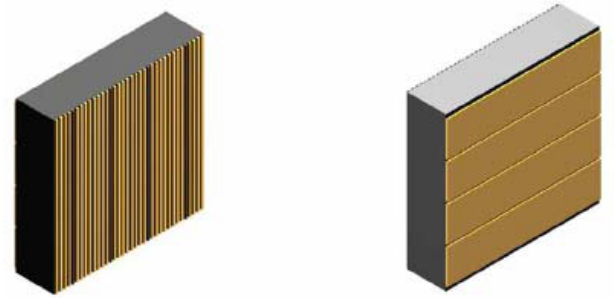
Figure 20 . The basic CdZnTe sensitive units; (left) anode side with microstrip pattern: the brown strips are the collecting anodes (0.10 mm wide), while the others (yellow) are the drift strips (0.15 mm wide); (right) cathode side with the four horizontal strip for the reconstruction of the interaction